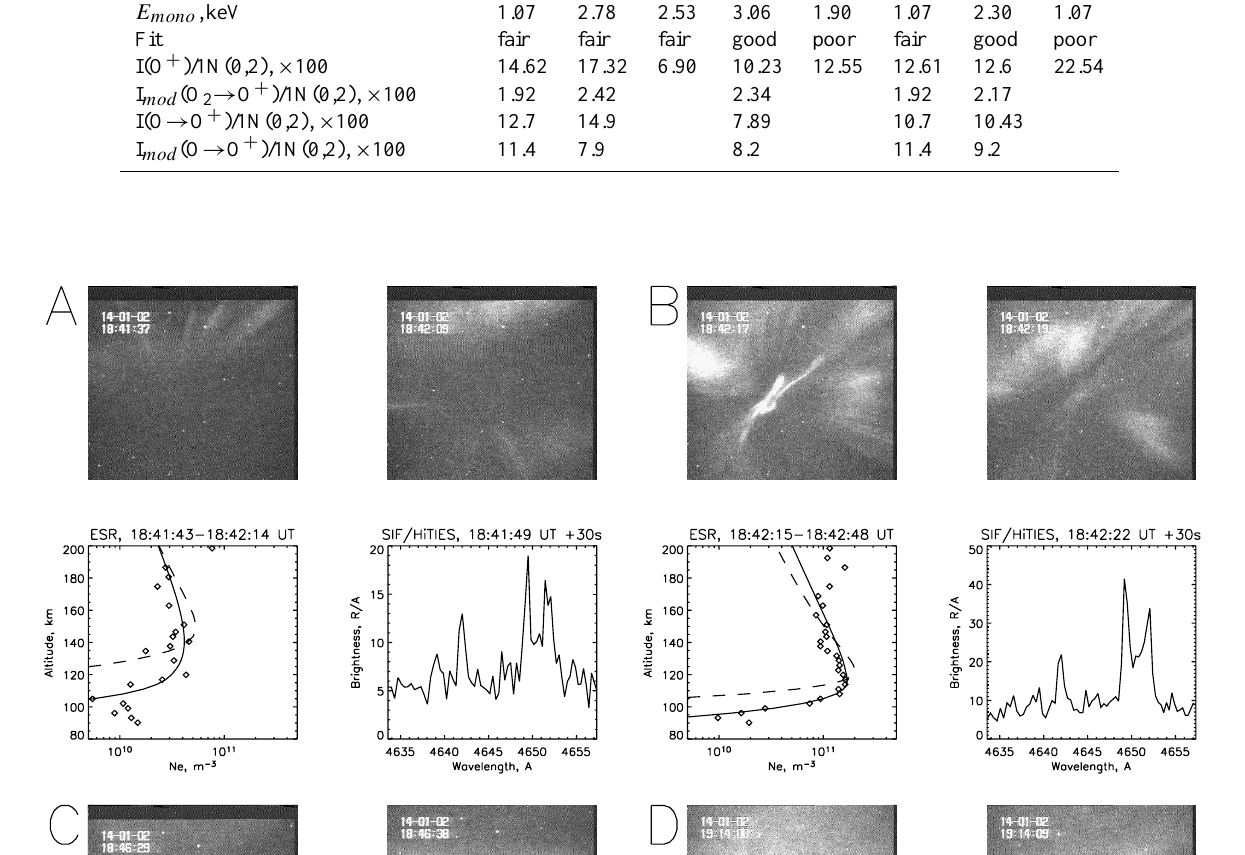
Table 2. Summary of the intervals on 14 January 2002: characteristic energy of the best fits for maxwellian and monoenergetic input electron spectra, quality of the fit, observed ratio of O + 4 P- 4 D 0 multiplet intensity to the N + O 2 dissociative ionisation/excitation, difference between the observed O + brightness and O 2 + e contribution, modeled brightness from O+ e assuming maximum cross section of 0.18 × 10 − 18 cm 2 .